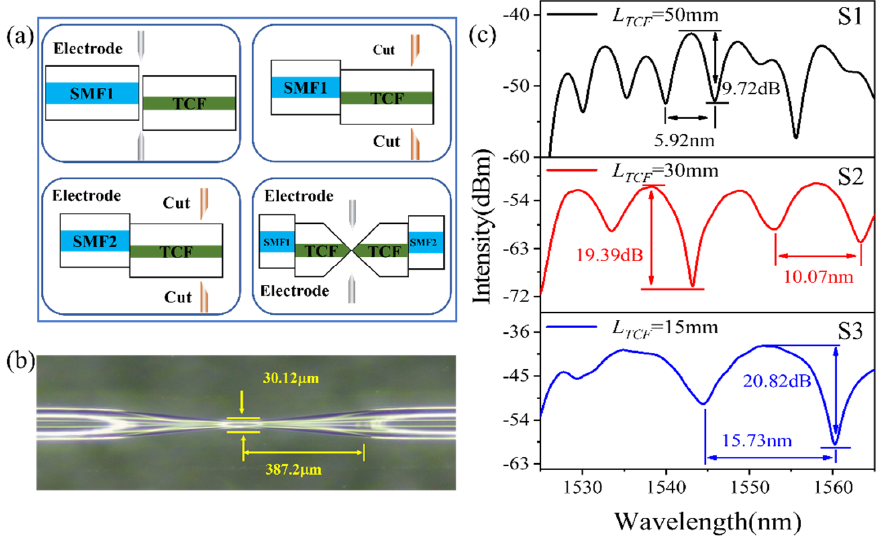
Table 2. Structural parameters of the samples. Samples